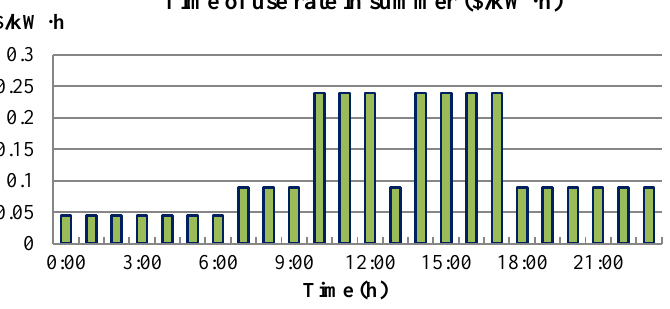
Figure 7. Electricity purchased/sold cost of the MG.